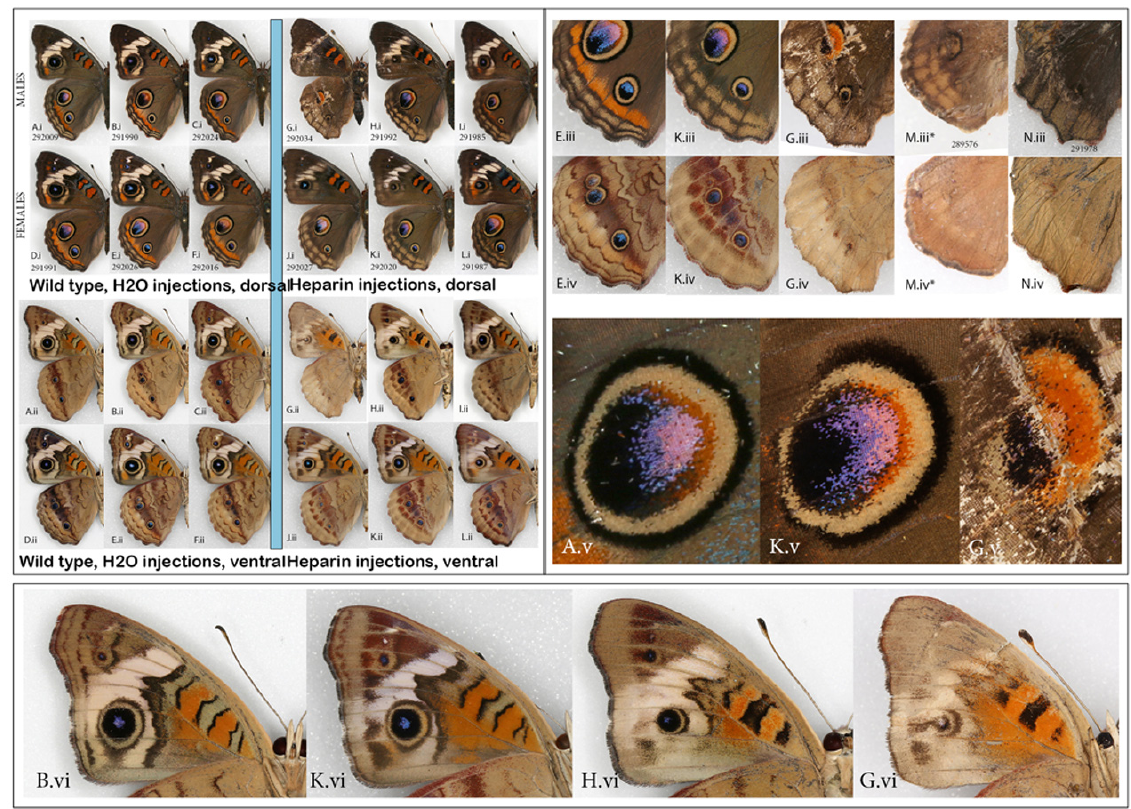
Figure 2. The common buckeye, Junonia coenia . Heparin-induced wing pattern changes (right) vs. controls (left) on the dorsal ( i ) and ventral ( ii ) surfaces. ( A – F ) Control group: ( A – C ) males and ( D – F ) females injected H O as prepupae. ( G – L ) Experimental group: ( G – I ) Males 2 and ( J – L ) females injected heparin as prepupae. For both groups, specimens shown are the ones in which the dorsal orange hindwing band was expressed the least. ( iii ) Close-up of HWd, ( iv ) Close-up of HWv, ( v ) Close-up of HWd large eyespot, ( vi ) Close-up of FWv. All showing gradual change as the heparin influence increases. *This individual was dissected out of the pupa, so figured is smaller un-inflated wing at larger relative size compared to the rest. See Extended Data (Sourakov, 2020) for